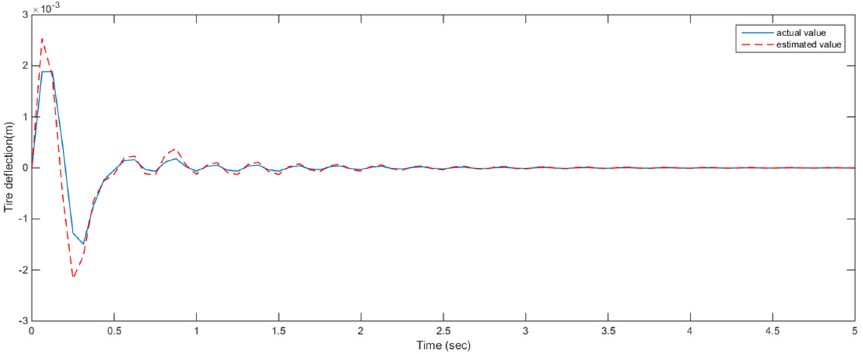
Figure 2. The actual and the estimated step response of tire deflection.